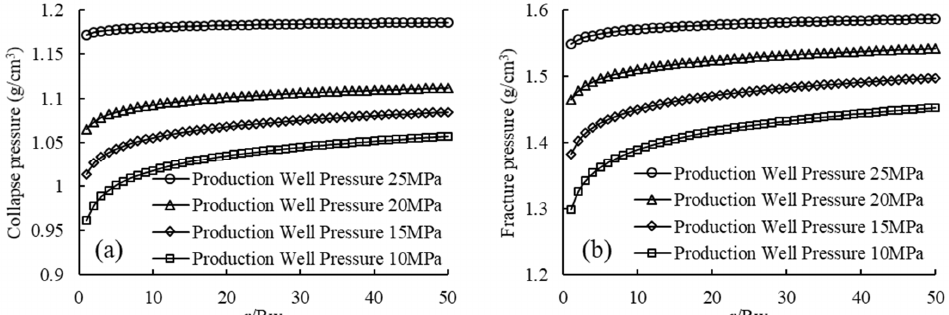
Figure 7. Reservoir collapse and fracture pressure change law of branch adjustment wells. ( a ): Col- lapse pressure evolution with different branch adjustment wells; ( b ): fracture pressure evolution with different branch adjustment wells.